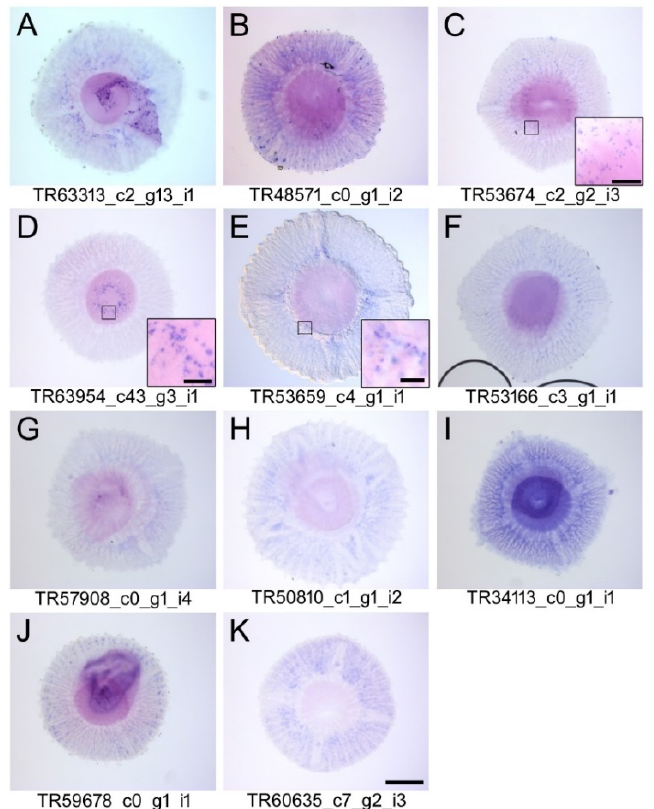
Figure A3. In situ hybridization screen panel 3. ( A – H ) Ventral view onto the tube foot disc. The distribution of the in situ hybridization signal (blue) is weak, but shows distinct expression in a subset of disc cells. Therefore, these transcripts represent proteins of unknown function. Scale bar, 200 µm.